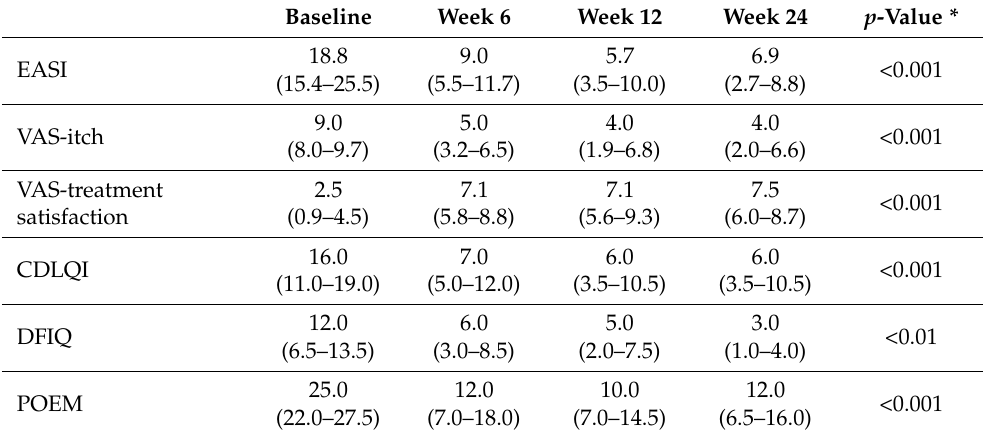
Table 3. Treatment efficacy in all patients presented as median scores (with interquartile range).